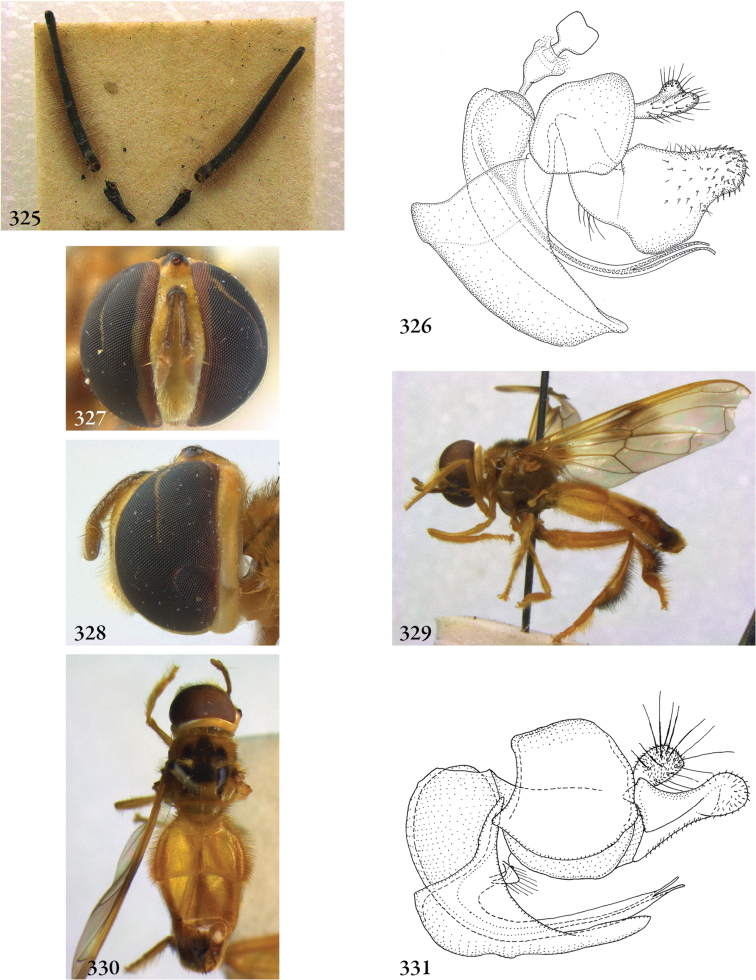
325–326
Ptilobactrum neavei male (holotype): 325 antennae 326 genitalia lateral 327–328
Rhoga sepulchrasilva male (Brazil, coll. USNM): 327 head frontal 328 head lateral 329–330
Rhoga mellea male (holotype): 329 habitus lateral 330 habitus dorsal 331
Rhoga sepulchrasilva male (Brazil, coll. USNM), genitalia lateral.